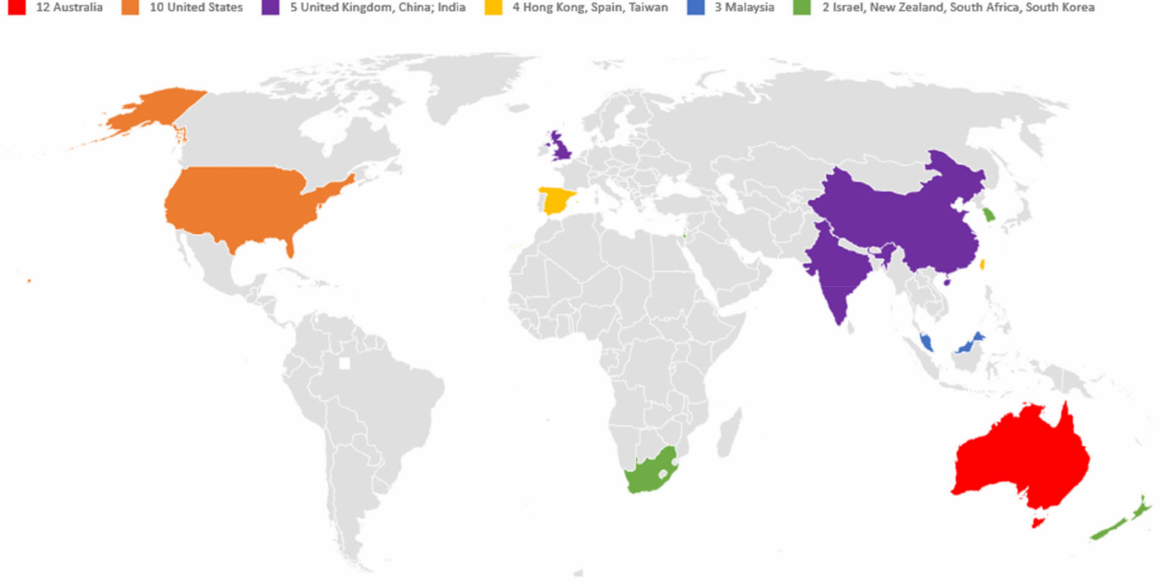
Figure 6. Top countries contributing to the subject of “Solo Travel” (at least two articles